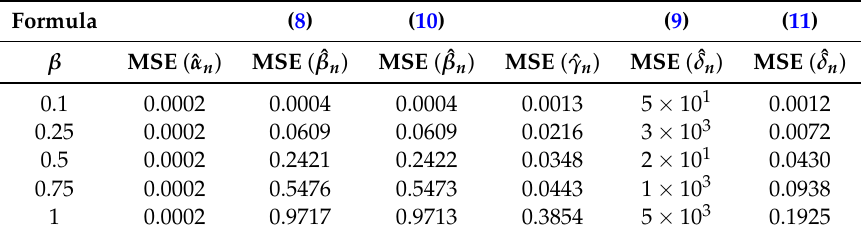
Table 3. MSEs of cumulant estimates for S ( α = 1, β ,1,0;1 ) , n = 10 − 5 .